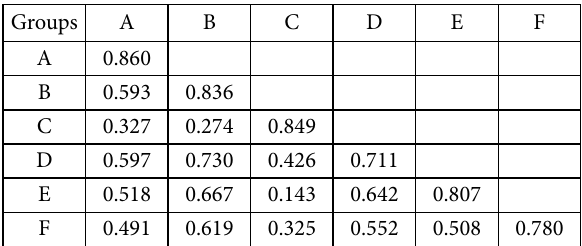
Table 4. Discriminant validity of the six